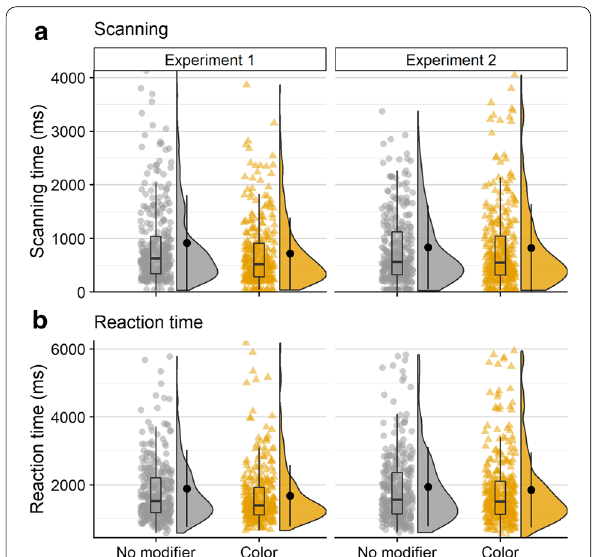
Fig. 13 Raincloud plots depicting data for scenes shared across both experiments, oriented vertically for legibility. Points on the left side of each raincloud show raw data. Box plots, superimposed over the raw data, indicate the median value (middle horizontal line), the first and third quartiles (top and bottom lines in box), and 1.5 interquartile range: the distance between the first and third quartiles (whiskers). Violin plots show the range (minimum and maximum) and density (width) of the data. Isolated points on the right side of each raincloud indicate the mean, and error bars on said points reflect one standard deviation. For ease of visualization, the bottom 99% of the